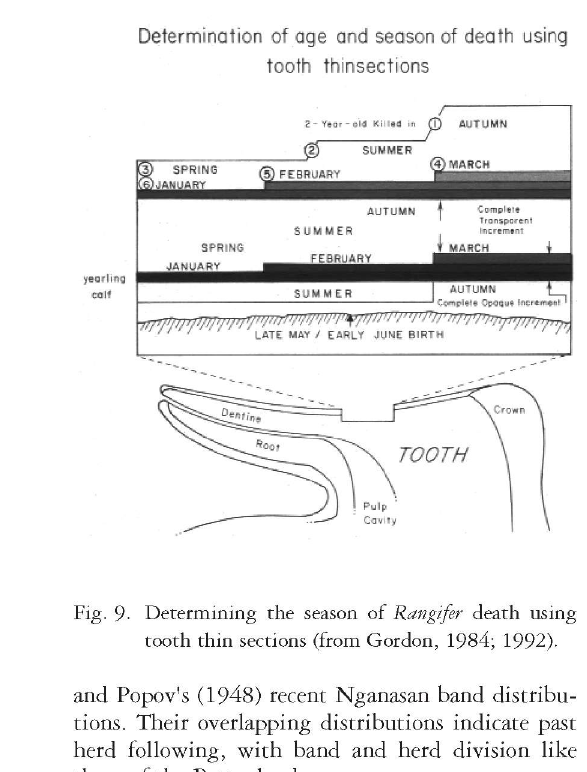
Fig. 9. Determining the season of Rangifer death using tooth thin sections (from Gordon, 1984; 1992). and Popov's (1948) recent Nganasan band distribu¬ tions. Their overlapping distributions indicate past herd following, with band and herd division like those of the